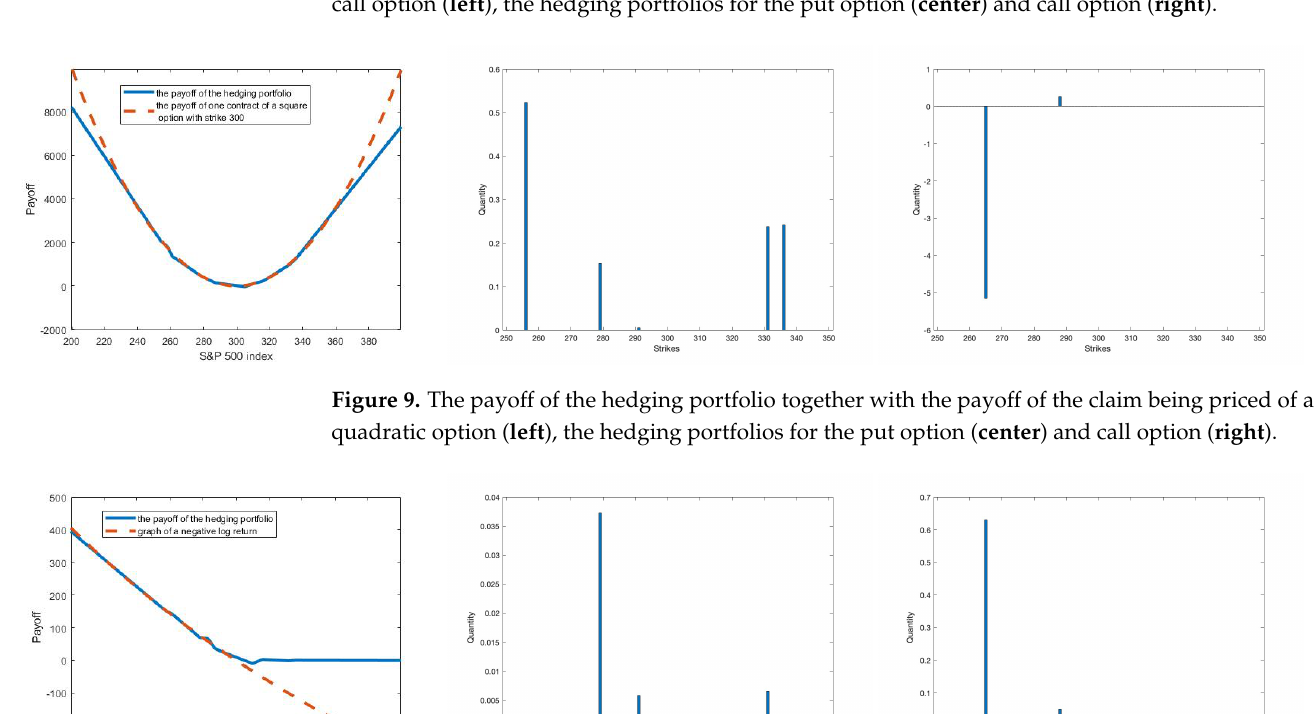
Figure 8. The payoff of the hedging portfolio together with the payoff of the claim being priced of a call option ( left ), the hedging portfolios for the put option ( center ) and call option ( right ).